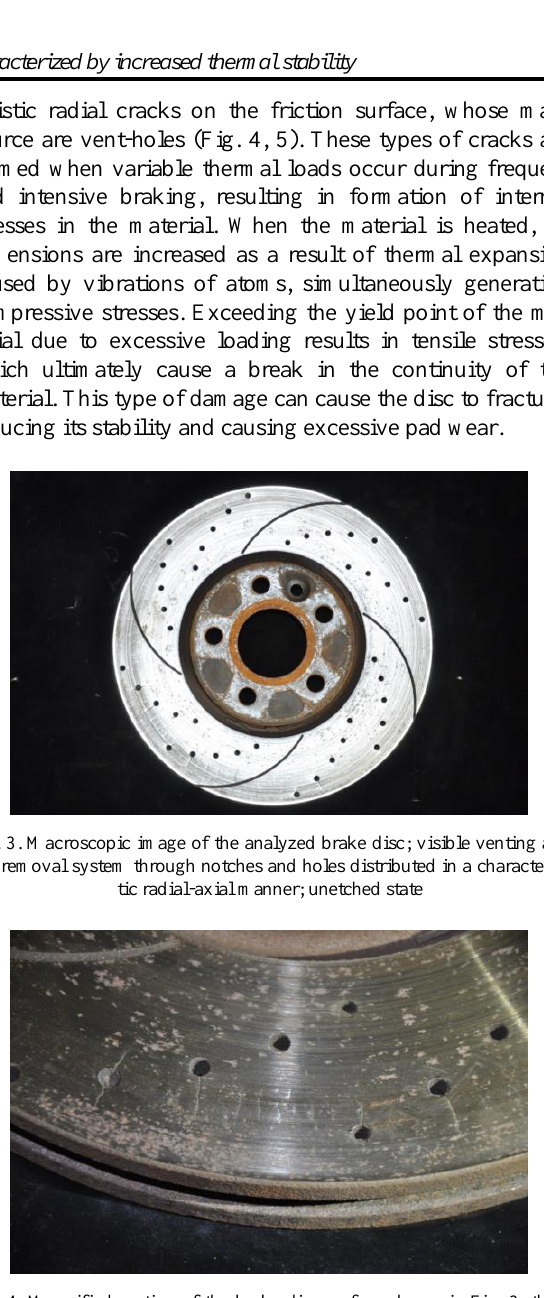
Fig. 4. Magnified section of the brake disc surface shown in Fig. 3; there can be observed radial cracks on the friction surface, which are